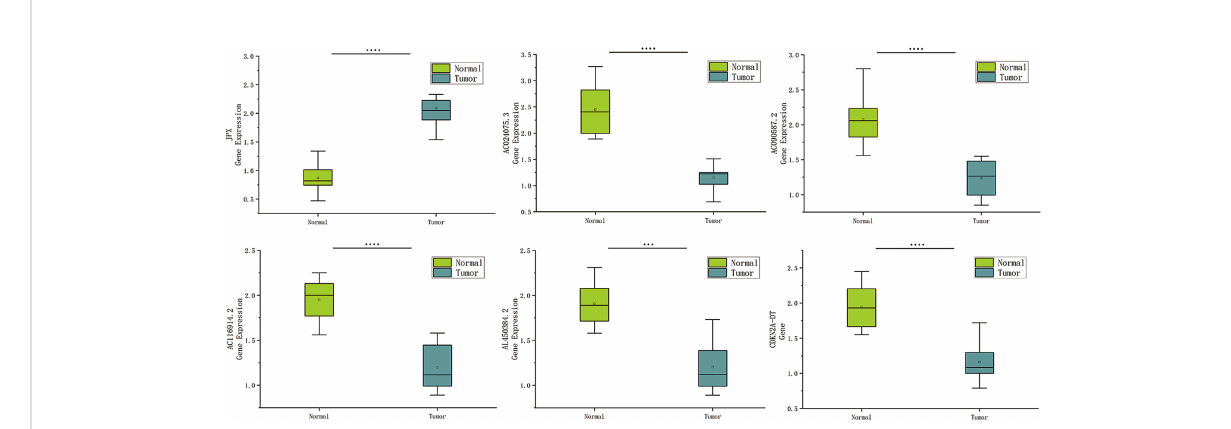
FIGURE 9 Expression of cuproptosis-related lncRNAs in HNSCC patients. Relative of RNA expression of six cuproptosis-related lncRNAs between cancerous and adjacent normal tissues. ***means p < 0.0001, ****means p <